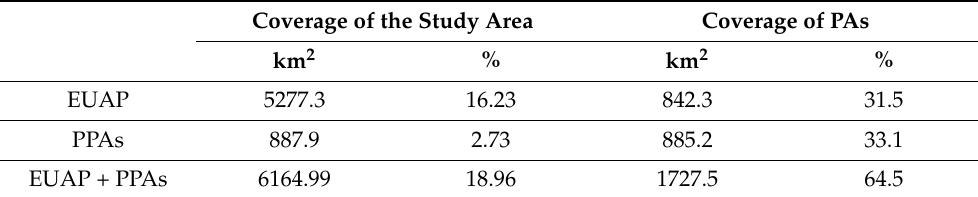
Figure 3. EUAP network (dotted), proposed protected areas (PPAs; the four identified patches are indicated by the letters A,B,C and D), and the ecosystem services’ priority areas (PA). Table 2. Study area and priority areas’ coverage by EUAP, PPAs, and by their